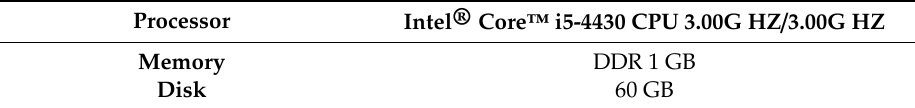
Table 2. Hardware specification.